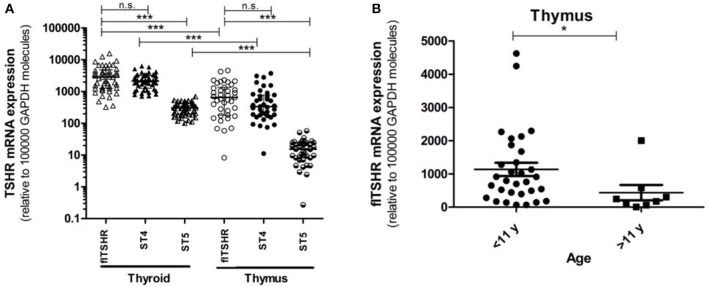
Gene expression of the TSHR isoforms in the thymus and thyroid. (A) mRNA expression of the full-length TSHR (flTSHR) and its isoforms (ST4 and ST5) in the thymus and thyroid. The relative level of mRNA expression was measured using quantitative PCR of the cDNA from 49 thyroid and 39 thymus samples. Each sample was tested in triplicate and the standard deviation was always <15% of the mean value. Values were normalized to GAPDH expression using the comparative CT method and expressed as copies per 100,000 copies of GAPDH. Each point represents the mean value of triplicate results from one sample. The median ± IQR of each group is shown. ***p < 0.0001, Kruskal Wallis test with a Dunn's multiple comparison test. (B) The relative mRNA expression of flTSHR in the thymus samples was stratified into pediatric (0–11 years; n = 31) and adults (40–80 years; n = 8) samples. The mean ± SEM of each group is shown. *p < 0.05 using a t-test for independent samples.